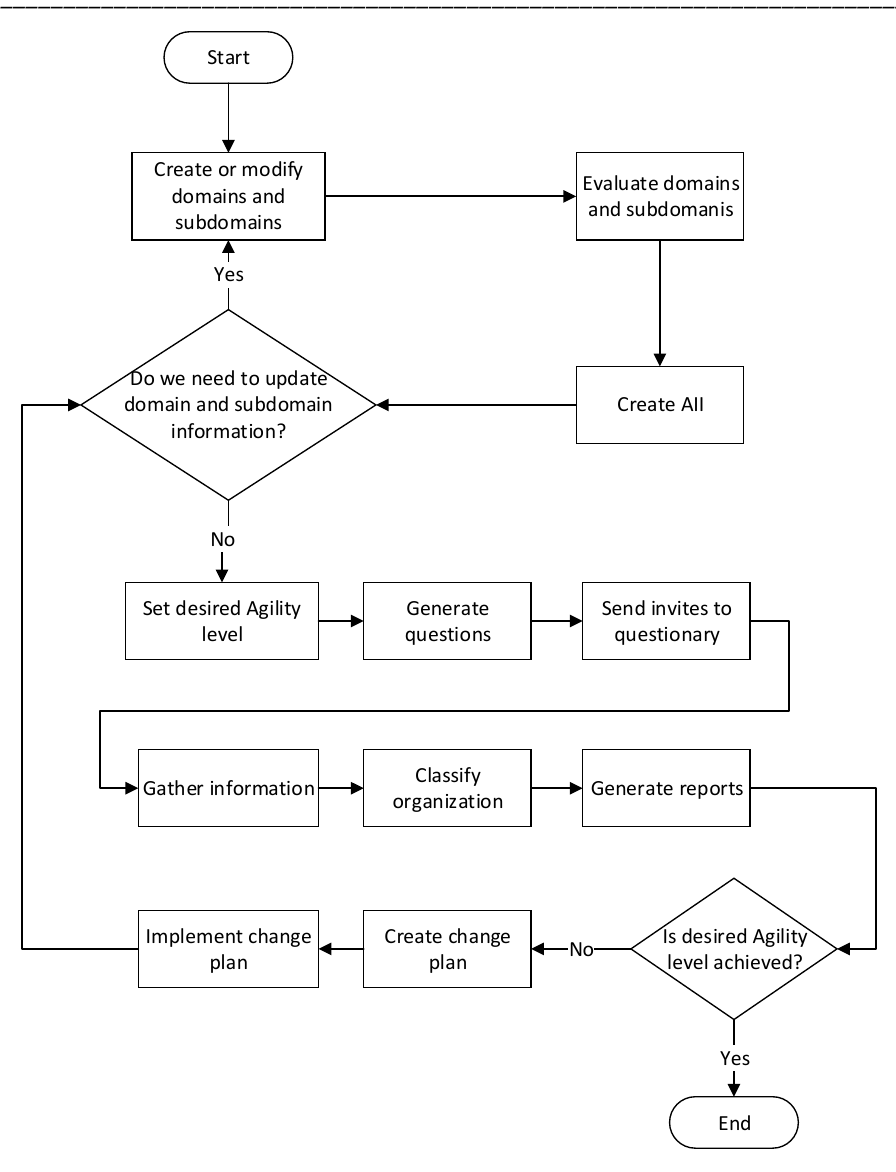
Fig. 3. Process of the ODA